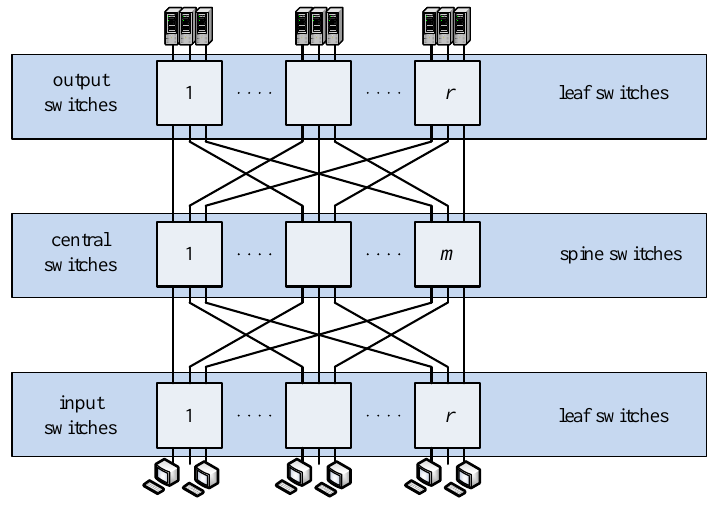
Figure 2. A three-stage Clos topology of a data